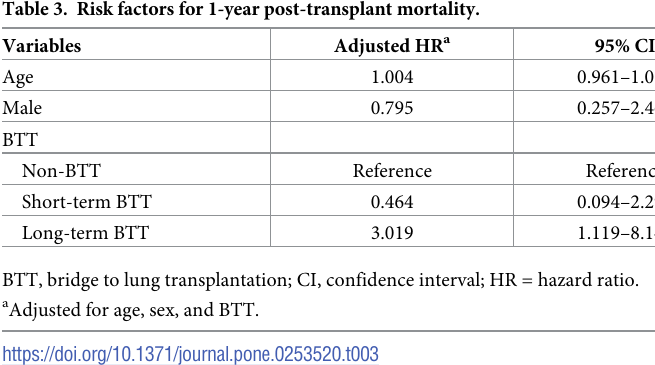
Table 3. Risk factors for 1-year post-transplant mortality.